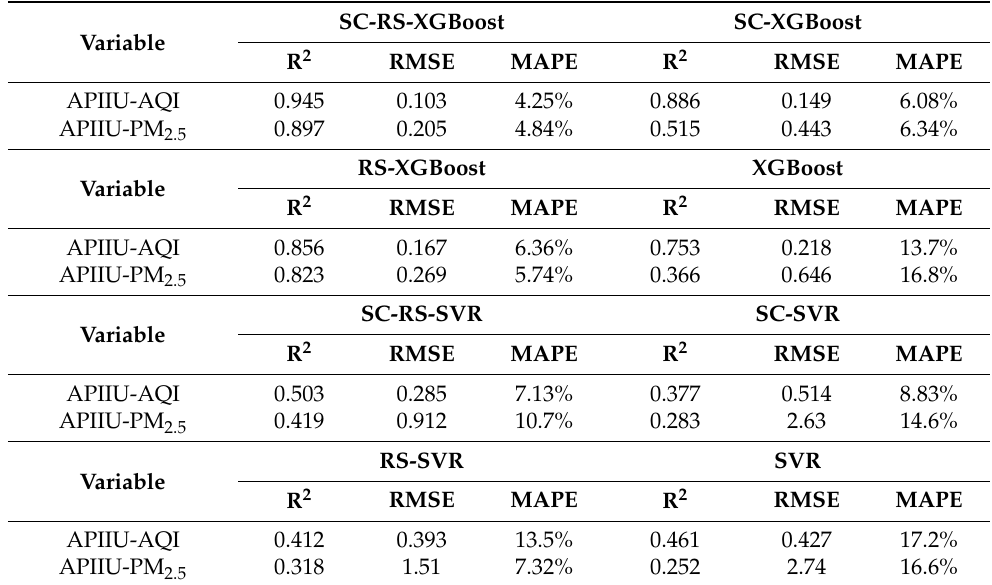
Table 4. Evaluation indicators of APIIU of each